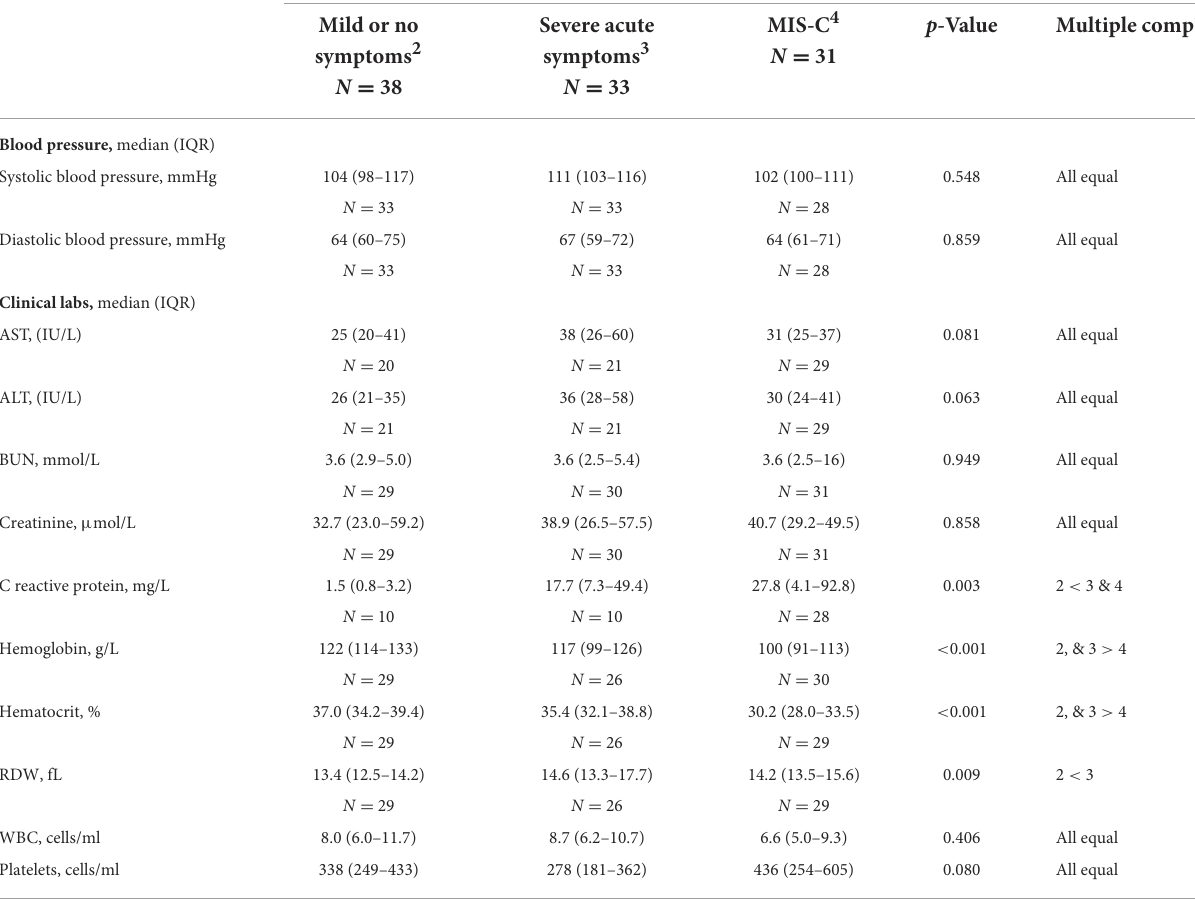
TABLE 2B Clinical laboratory data for patients with